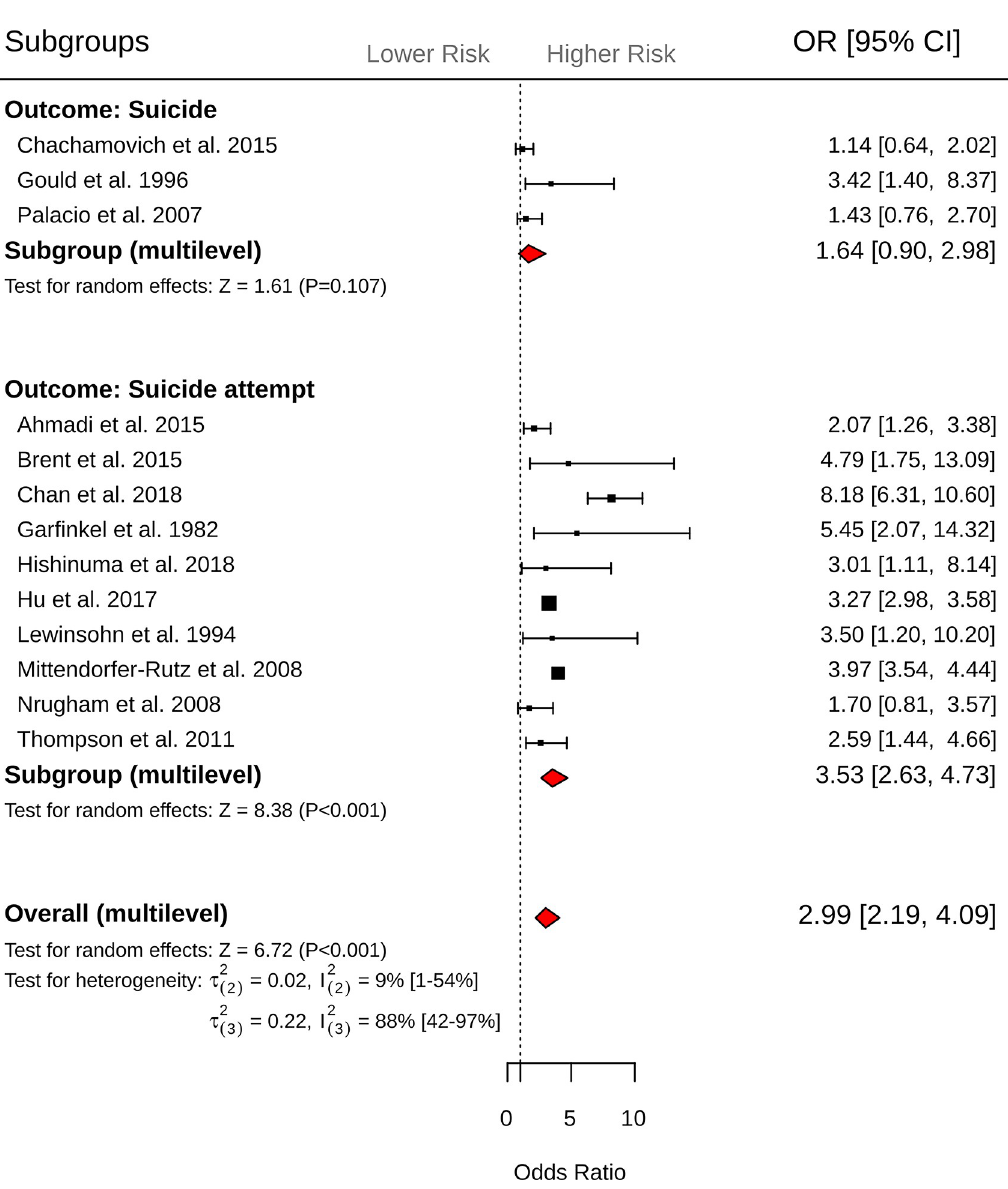
Fig 3. Forest plots of exposure to suicide attempt and subsequent suicide and suicide attempt outcomes. CI, confidence interval; OR, odds